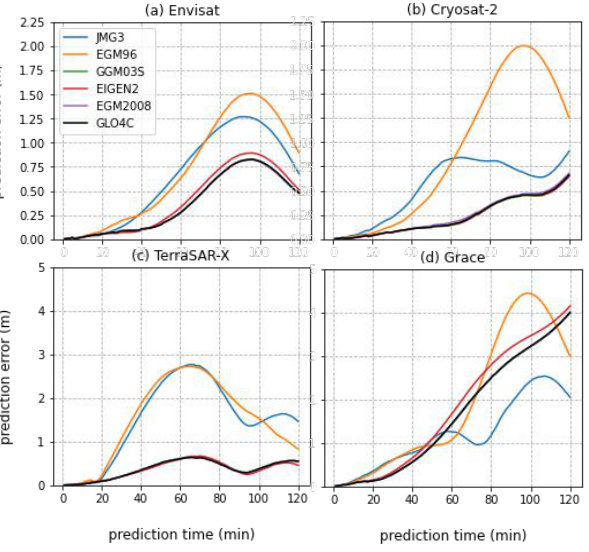
Figure 1. 3D Prediction error with different gravity